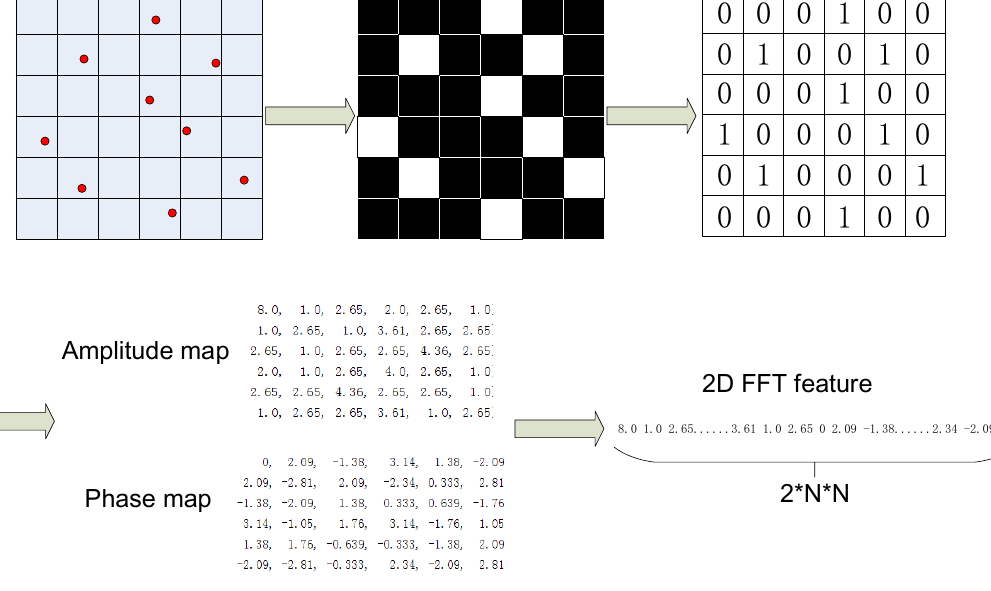
Figure 7. Explanation of